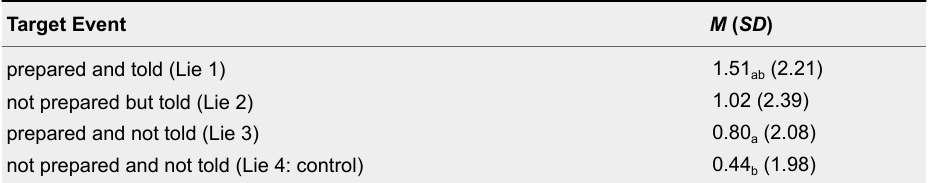
Mean (SD) Change Scores for Experiment